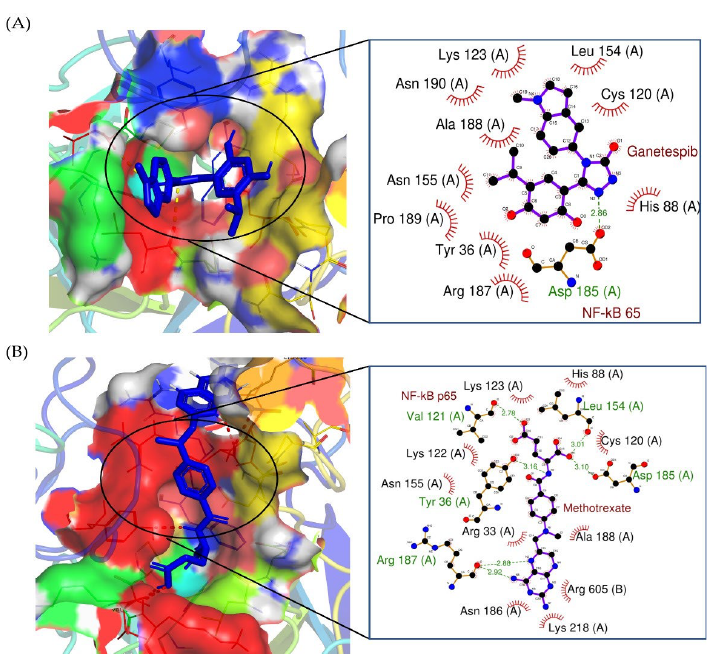
Figure 8. Two-dimensional interaction complex of ( A ) GAN and ( B ) MTX with NF- κB/p65 protein, where red shows the target protein, purple shows the ligand molecule, and the black circle shows the enlarged view of the docked